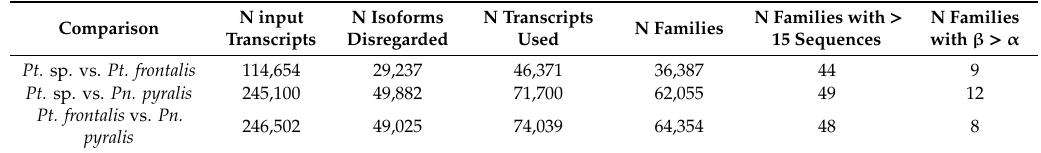
Table 3. FUSTr results. Comparison = the two species FUSTr compared in its analysis. N input transcripts = number of transcripts input into FUSTr. N isoforms disregarded = number of isoforms removed from analysis. N transcripts used = number of transcripts used by FUSTr. N families = number of gene families found in each comparison. N families with > 15 sequences = number of gene families with greater than 15 sequences. N families with β > α = number of gene families found to be under strong positive